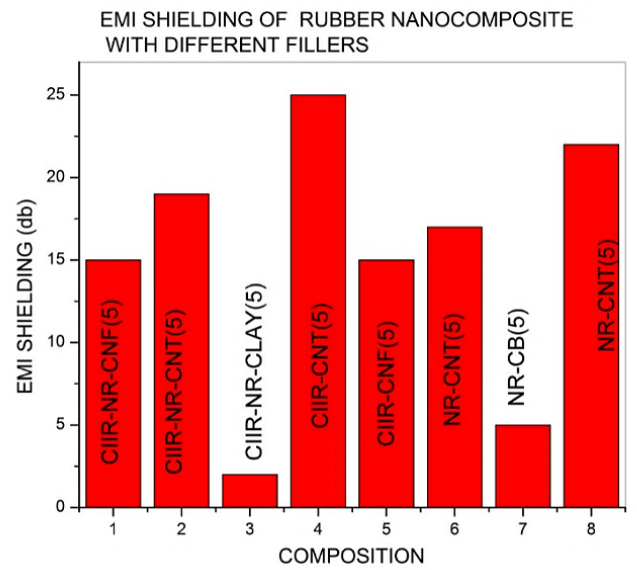
Figure 18. EMI Shielding versus composition graph of rubber nanocomposite with different fillers. CIIR shows the best results for EMI shielding when compared to the blend system and plane NR. The fillers CNT and CNF showed the good values of EMI shielding.